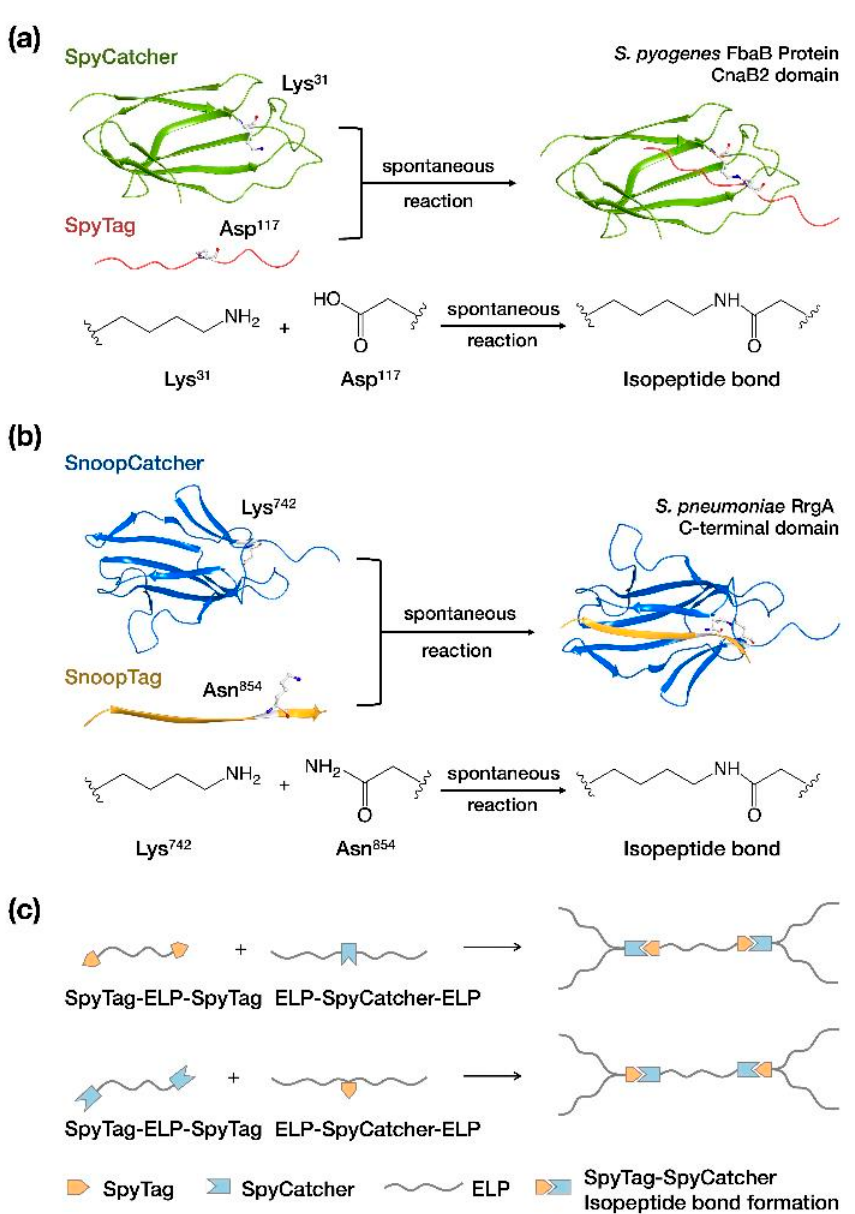
Figure 4. The spontaneous isopeptide bond formation by di ff erent Catcher/Tag reactions. ( a ) The spontaneous isopeptide bond formation by different Catcher/Tag SpyTag–SpyCatcher (PDB entry: 4MLI) and ( b ) SnoopTag–SnoopCatcher (PDB entry: 2WW8). ( c )